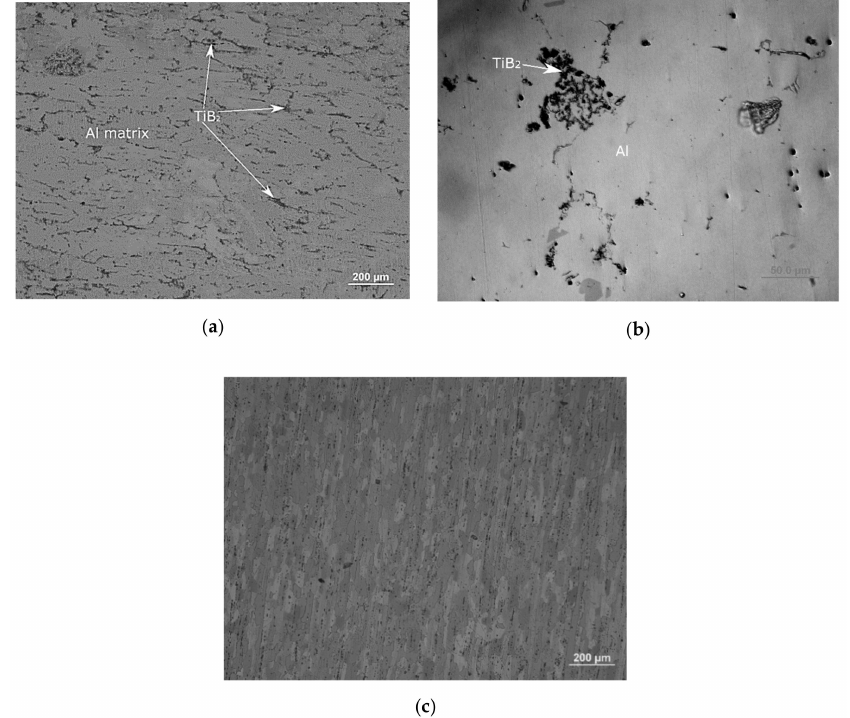
Figure 10. Microstructure of the AA5056 + MA3 US alloy after pass rolling ( a ) and cast AA5056 + MA3 US ( b ), AA5056 US ( c